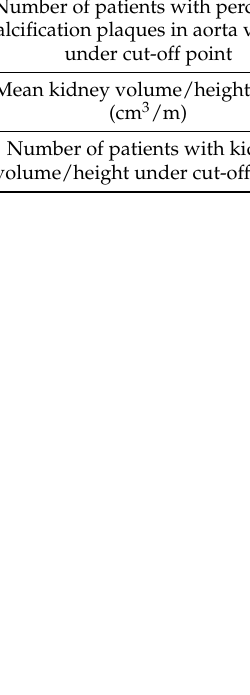
Table 5. Risk factors for 30-day